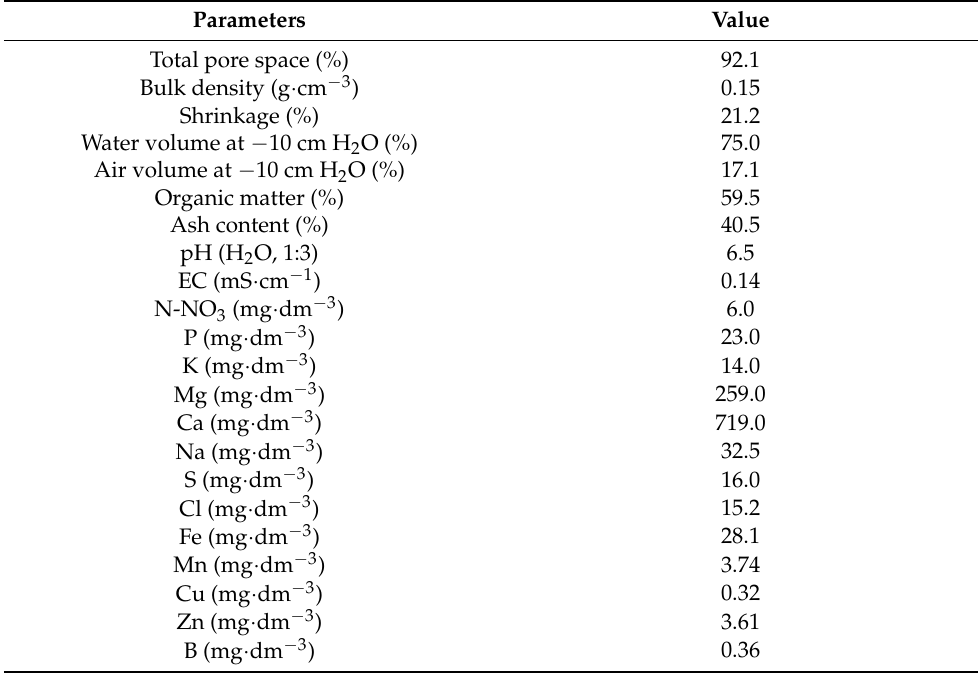
Table 1. Physical and chemical properties of the substrate used in the experiment.